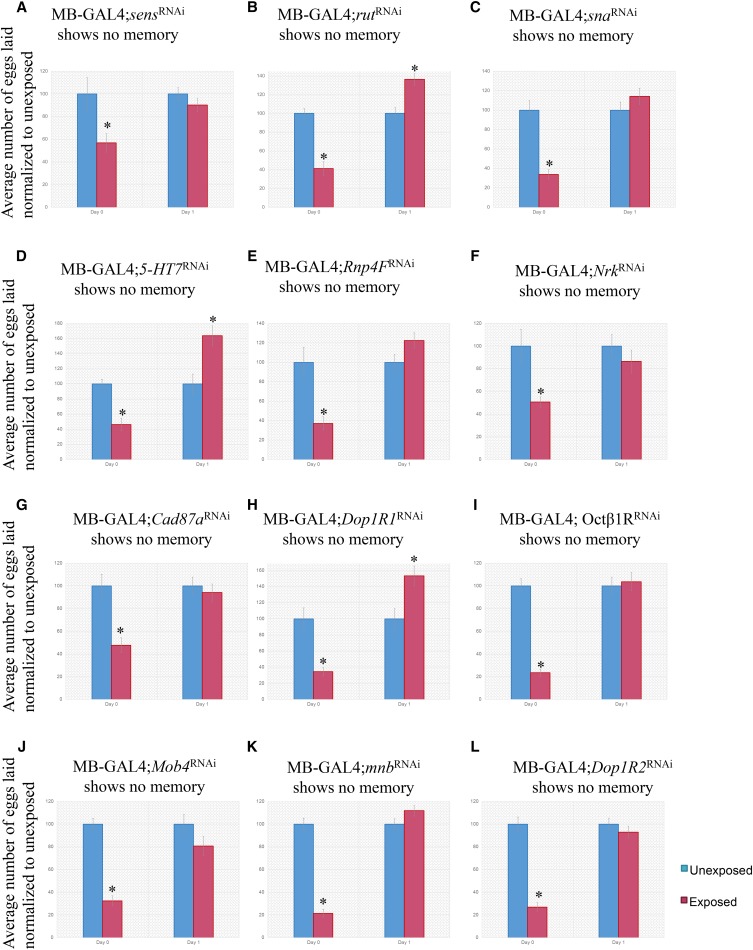
Expression of several genes in the mushroom body is necessary for long-term memory formation. Percentage of eggs laid by exposed flies normalized to eggs laid by unexposed flies is shown. Flies exposed to wasps with various RNAi-hairpins expressed in the MB using the MB247 driver show no memory response for sensRNAi (A), rutRNAi (B), snaRNAi (C), 5-HT7RNAi (D), Rnp4FRNAi (E), NrkRNAi (F), Cad87ARNAi (G), Dop1R1RNAi (H), Octβ1RRNAi (I), Mob4RNAi (J), mnbRNAi (K), and Dop1R2RNAi (L). Error bars represent standard error (n = 12 biological replicates) (*P < 0.05).